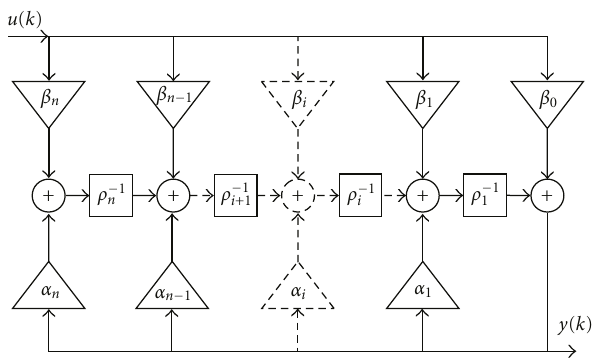
Figure 2: Generalized ρ Direct Form II.